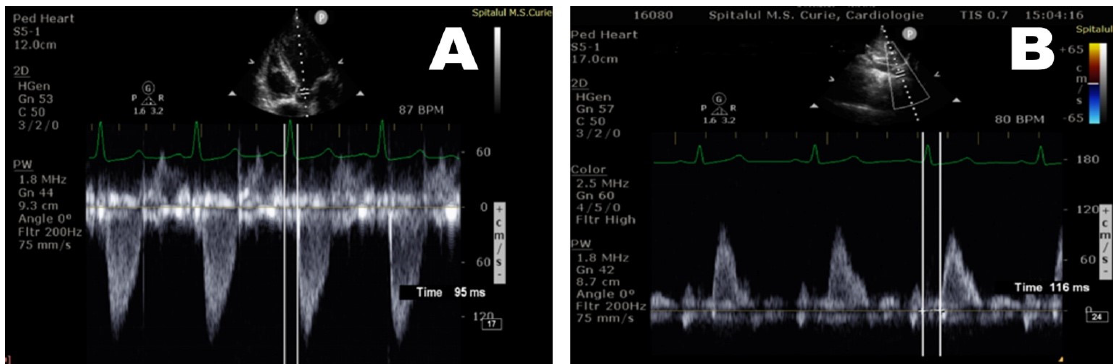
Figure 3. Measurement of Δ T2 (T2-T1 = 116 − 95 = 21 ms) in the descending aorta—echocardiography 5C apical window ( A ) and subcostal view ( B ).